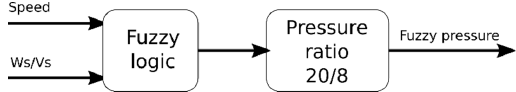
Figure 6. Block scheme of the speed controller.